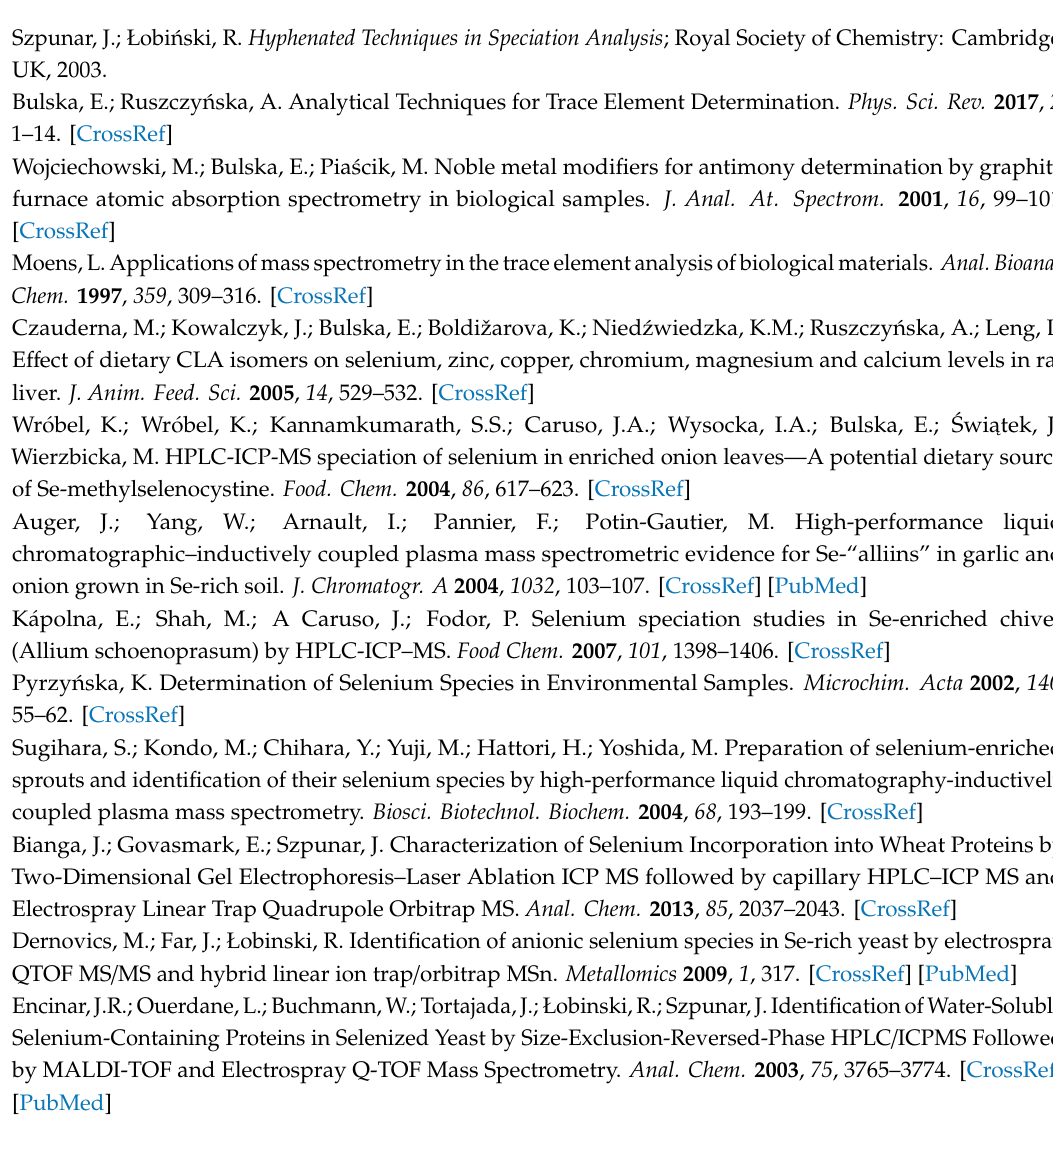
Figure S1: title, Table S1: title, Video S1: title. Figure S1. MS spectrum registered for the ion of 5 (cid:48) -seleno adenosine with m / z 332.0242, with isotopic pattern characteristic for selenium compounds. Figure S2. MS spectrum registered for the ion of 2,3-DHP-selenolanthionine with m / z 345.0193, with isotopic pattern characteristic for selenium compounds. Figure S3. MS spectrum registered for the ion of Se-S conjugate of cysteino-selenoglutathione with m / z 475.0393, with isotopic pattern characteristic for selenium